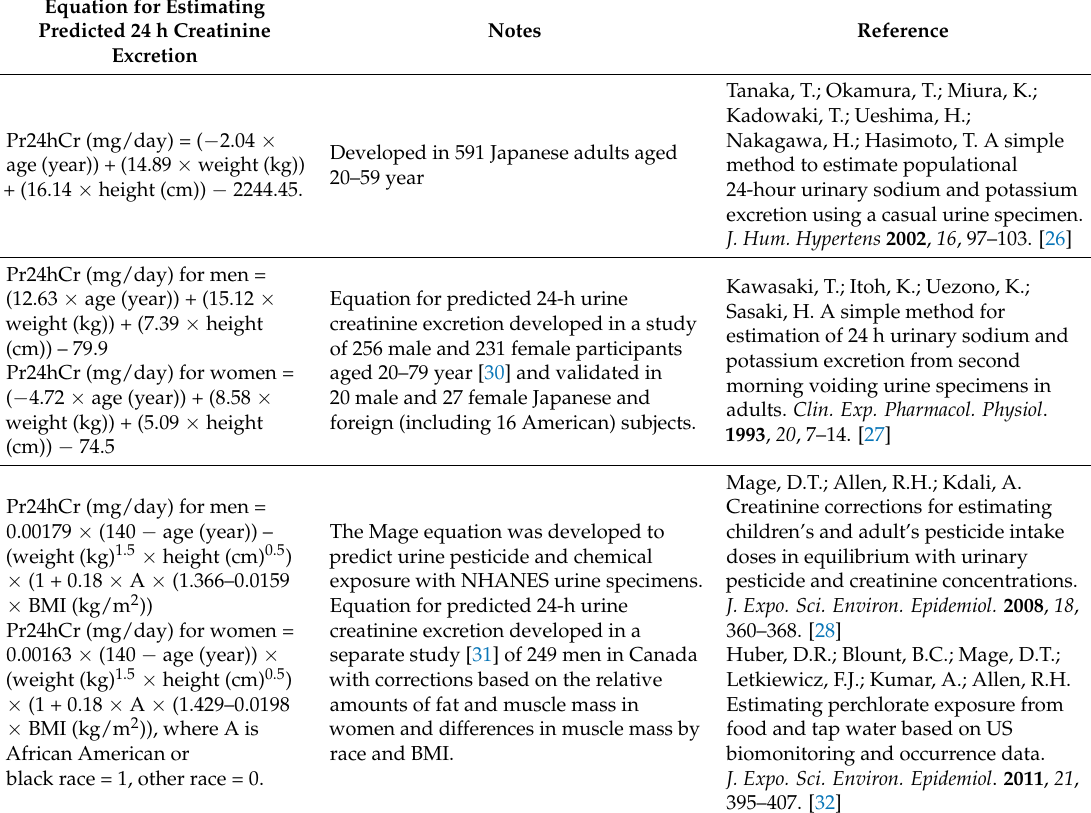
Table adapted from Cogswell et al. (2013)